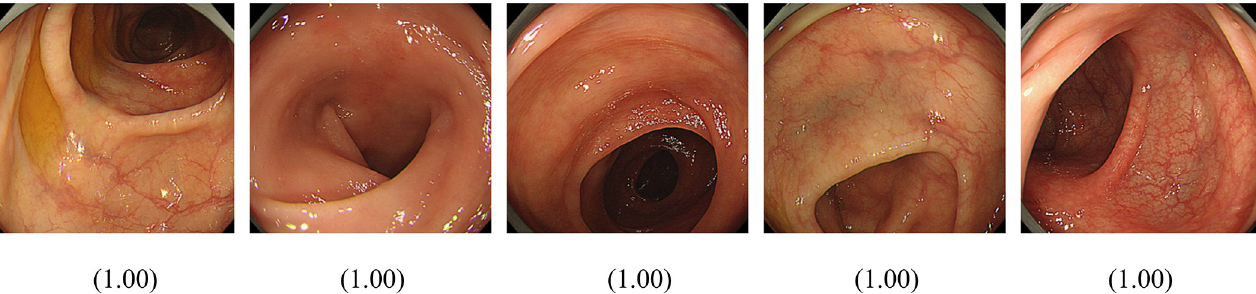
Fig 7. Images that scored high (0 to 1) in the colon image AI model for detecting Group C are shown. Values shown correspond to score.